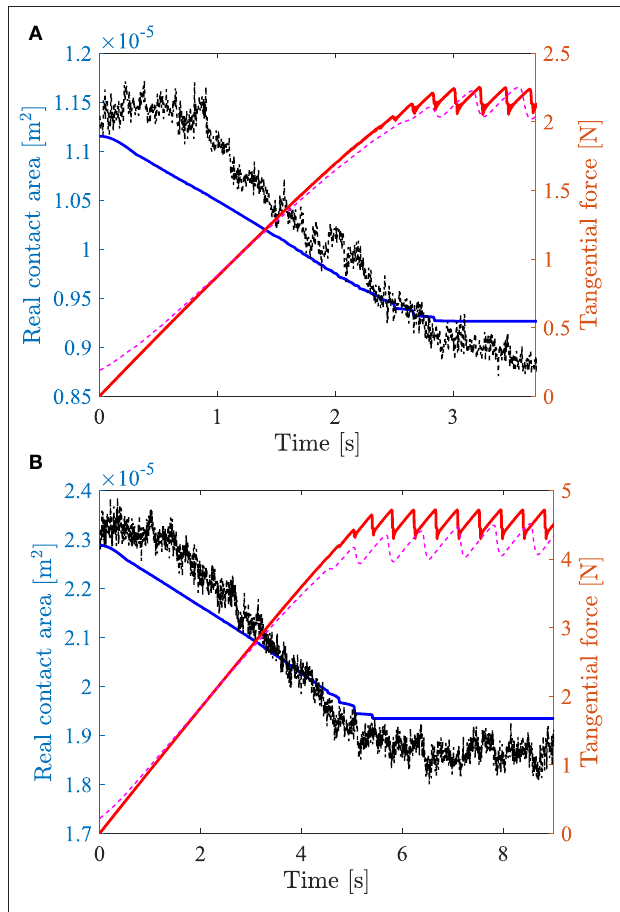
FIGURE 3 | Direct comparison between measurements and model predictions, for two typical experiments with either P = 1.53 N (A) or P = 3.10 N (B) . Time evolutions of the measured (dashed, black) and predicted (solid, blue) area of real contact, and of the measured (dashed, magenta) and predicted (solid, red) tangential